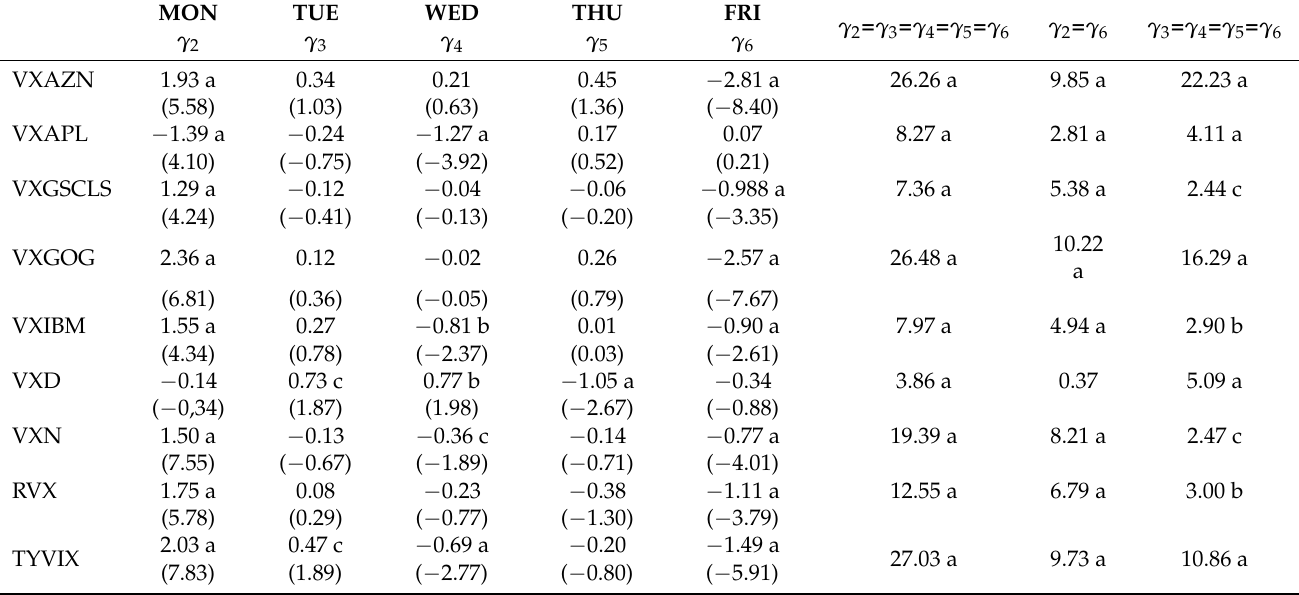
Table 10. Testing the residuals of Equation (3).